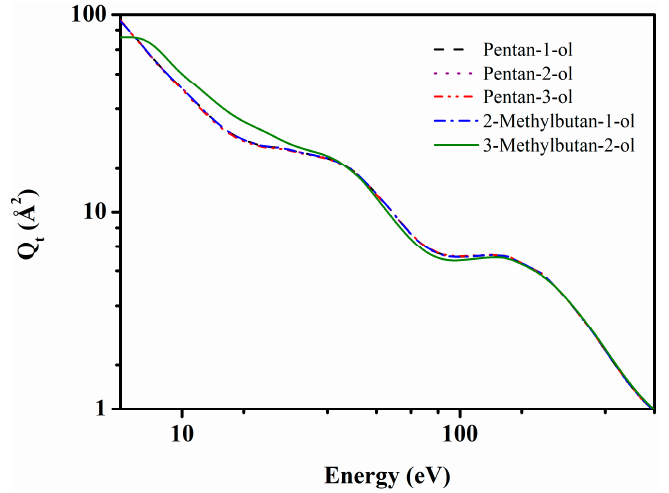
Figure 13. Momentum transfer cross-section of pentanol isomers: dashed (black) line represents penta-1-ol, dotted (purple) is for pentan-2-ol, dash-dot-dot (red) line is for pentan-3-ol, dash-dot (blue) line represents 2-methylbutan-1-ol and solid (olive) line represents 3-methylbutan-2-ol